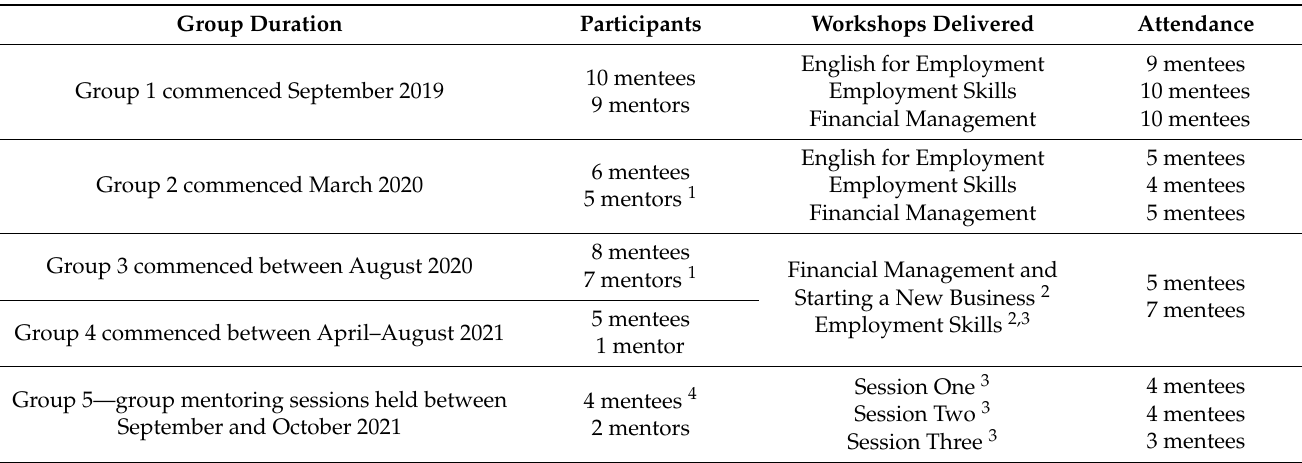
Table 1. Table of participant cohorts and workshops